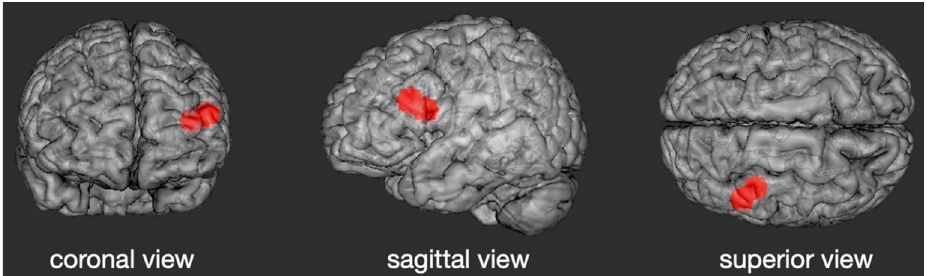
Figure 1. Location of the ROI mask representing the left-hemispheric ALE-cluster used in the seed-based connectivity